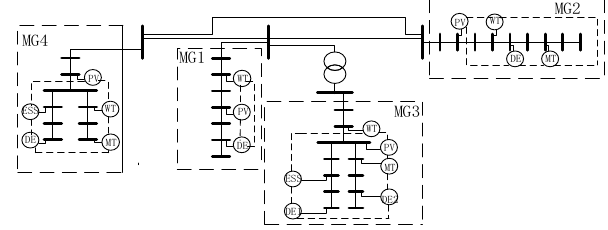
Figure 6. Topology of multi-microgrid system.